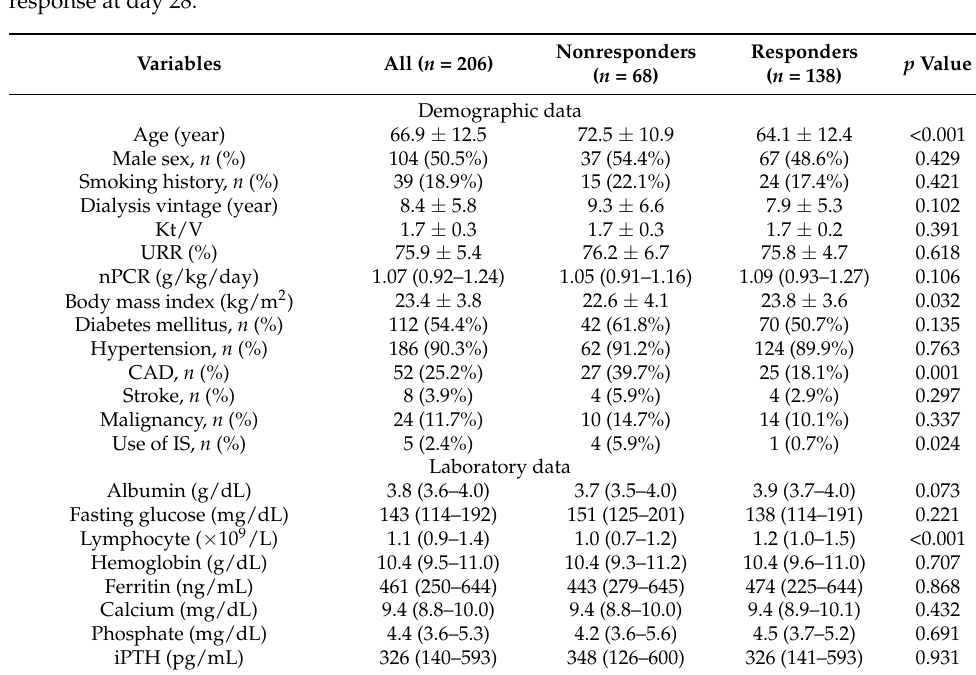
Figure 1. Patient flow diagram. Table 1. Baseline characteristics of hemodialysis patients according to their anti-spike IgG antibody response at day